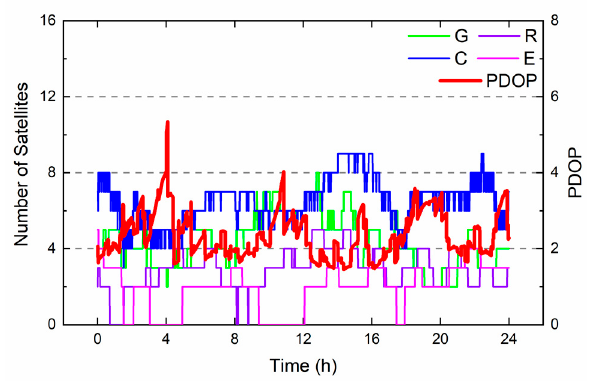
Figure 4. Number of usable satellites in case 3 (green: GPS; violet: GLONASS; blue: BDS; magenta: Galileo) and position dilution of precision (PDOP) values of multi-GNSS (red).